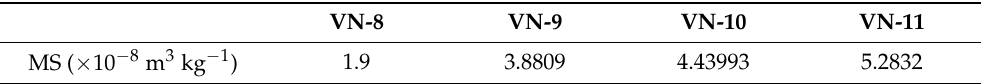
Table 3. Results of the MS measurements at the Voorthuizen archaeological